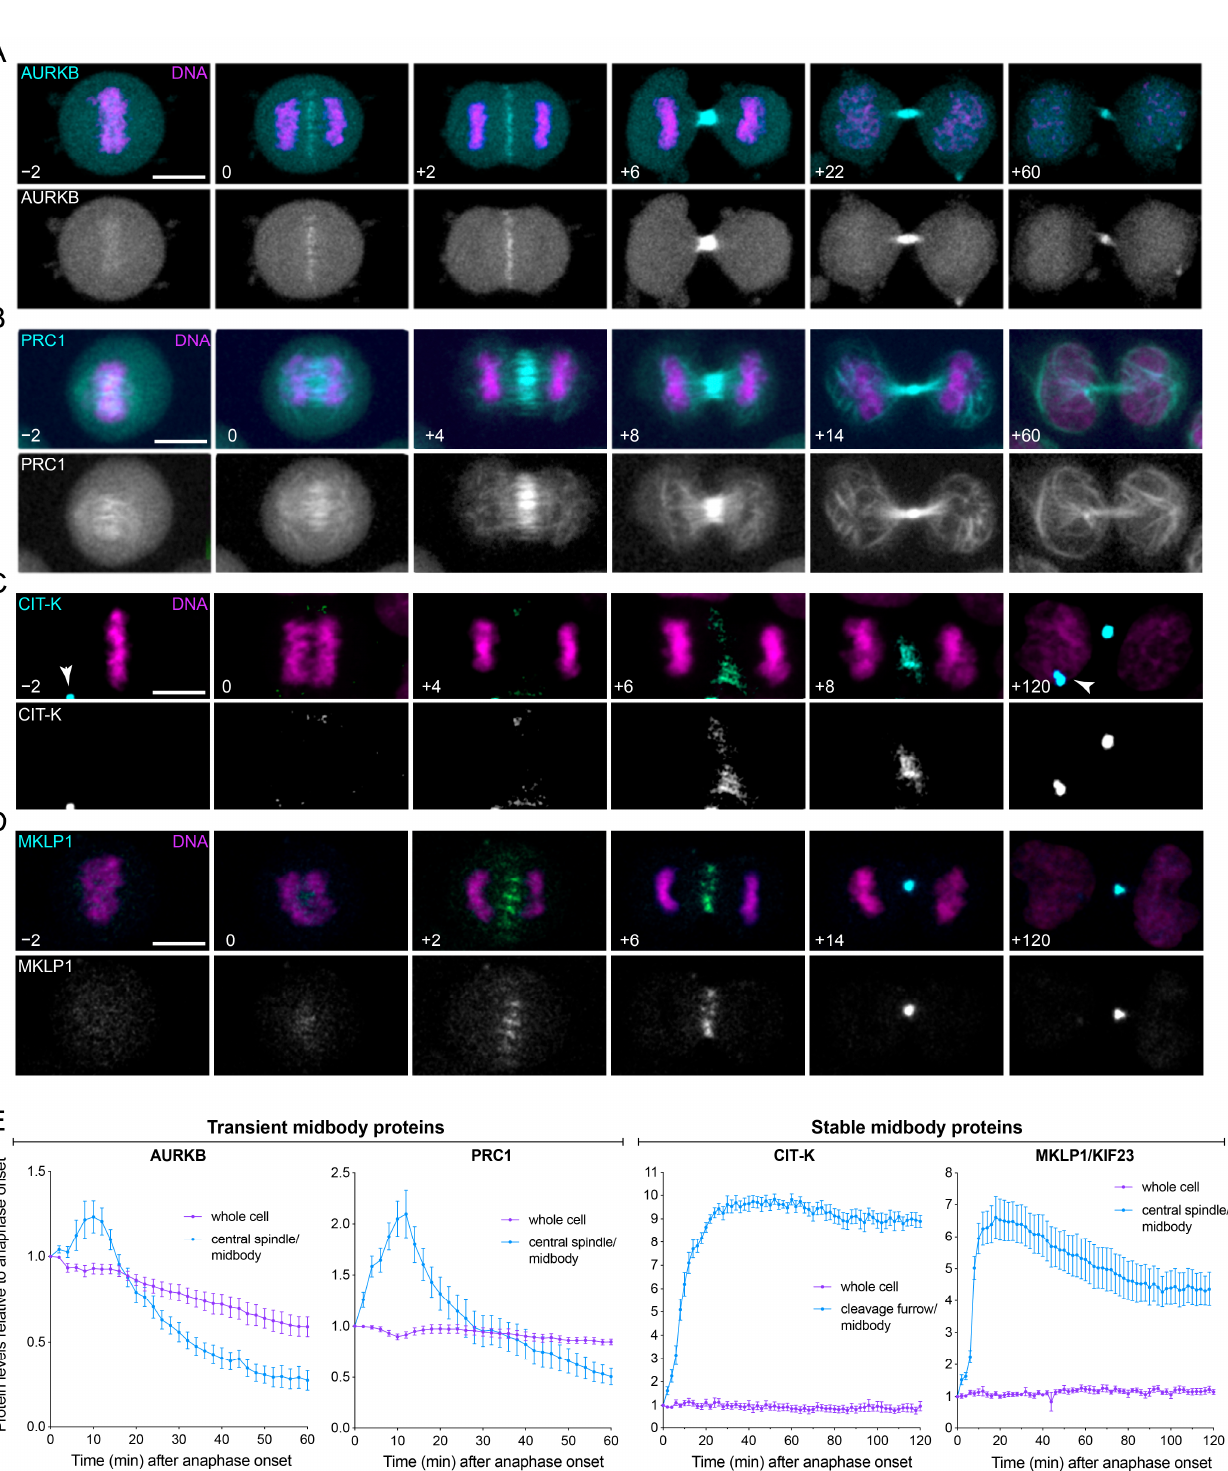
Figure 3. Midbody proteins display distinct dynamics during cytokinesis. ( A – D ) Selected images from time-lapse recordings of HeLa cells expressing GFP-tagged AURKB ( A ), PRC1 ( B ), CIT-K ( C ) and KIF23/MKLP1 ( D ). Chromosomes were visualized using SiR-DNA. GFP-tagged proteins are in cyan and DNA in magenta in the merged panels. Time is in minutes relative to anaphase onset (0 time point). The arrowheads in ( C ) mark CIT-K::GFP localization to post-mitotic midbodies. Bars, 10 µm. ( E ) Quantification of midbody proteins during cytokinesis. Fluorescence intensity values were measured in whole cells and at the central spindle/cleavage furrow/midbody and then normalized relative to the anaphase onset (0) time point. Bars indicate SEM, n = 10.